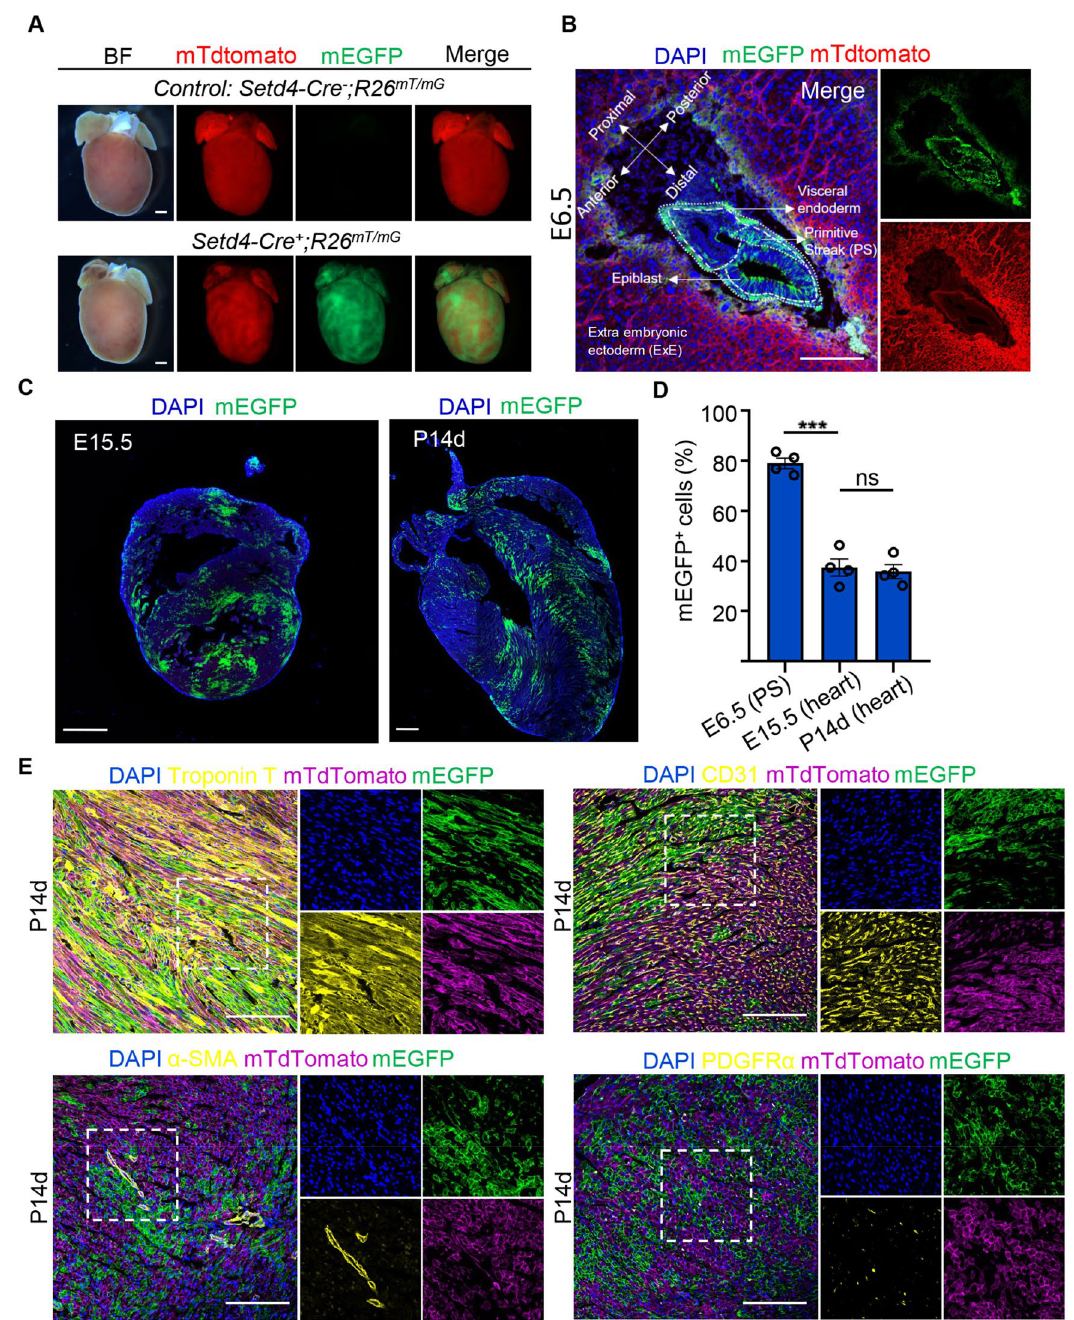
Figure 3. Setd4 + cells contribute to cardiac development in embryos. ( A ), Fluorescent images of hearts of Setd4- Cre + ;Rosa26 mT/mG mice and the control Setd4-Cre − ;Rosa26 mT/mG mice. Scale bars = 500 μm. ( B , C ) Representative immunofluorescence for recombinant mG + cells in E6.5 germ layers ( B ), E15.5 and P14 hearts ( C ). PS: primitive streak; ExE: extra embryonic ectoderm. Scale bars = 500 μm. ( D ) Quantification for recombinant mG + cells in E6.5 PS, E15.5 and P14 hearts. ( E ) Representative immunofluorescence for recombinant mG + cells with cardiomyocyte, EC, smooth muscle cell and fibroblast markers, Troponin T, CD31, α-SMA and PDGFRα, respectively, in the P14 heart. Scale bars = 50 μm. Nuclei were stained with DAPI. All data are represented as mean ± SEM. n = 4 mice. One-way ANOVA with Bonferroi’s correction for multiple comparisons test for ( D ). *** p < 0.001, ns: not